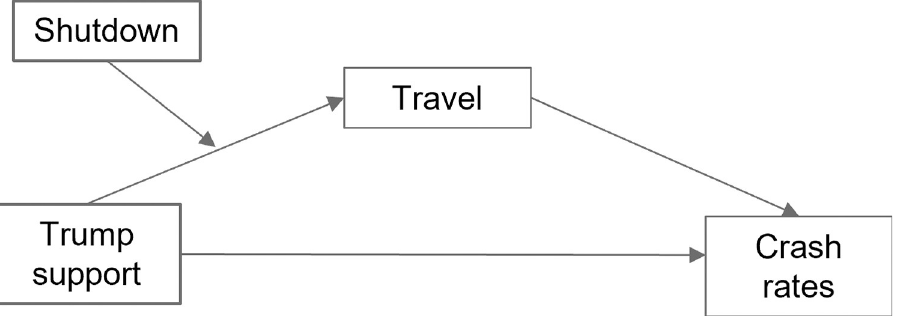
Fig 4. Hypothesized moderated mediation